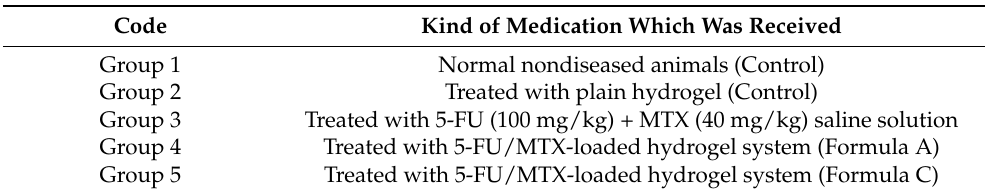
Table 8. Classification of the investigated animals according to the kind of medication which was taken during the